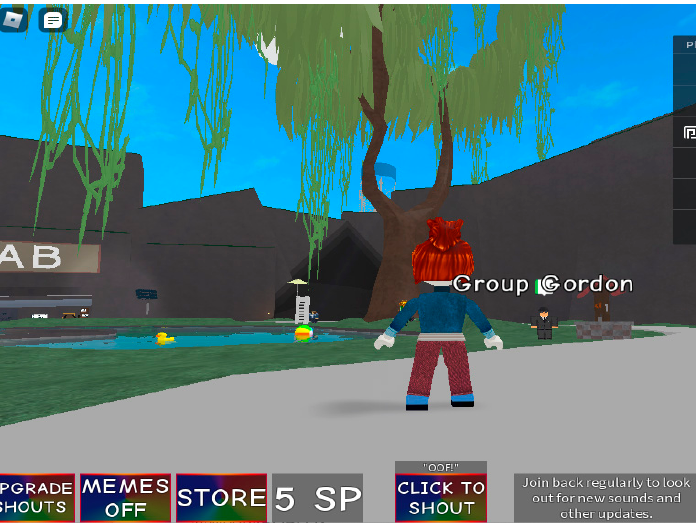
Figure 7. Screenshot of a Roblox game “Shouting Simulator” in which the first author (the avatar with red hair) can click on an icon to shout, “oof,” to communicate with other players, in addition to using the free chat.